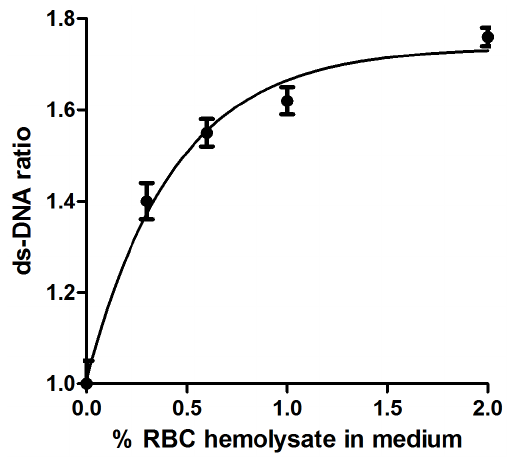
Figure 3. Dose-response curve of the effect of RBC hemolysate (% v / v in medium) on ds-DNA ratio in H 2 O 2 -stimulated PBMC. p , 0.001 for the effects of the 0.3, 0.6, 1 and 2% v / v RBC hemolysate